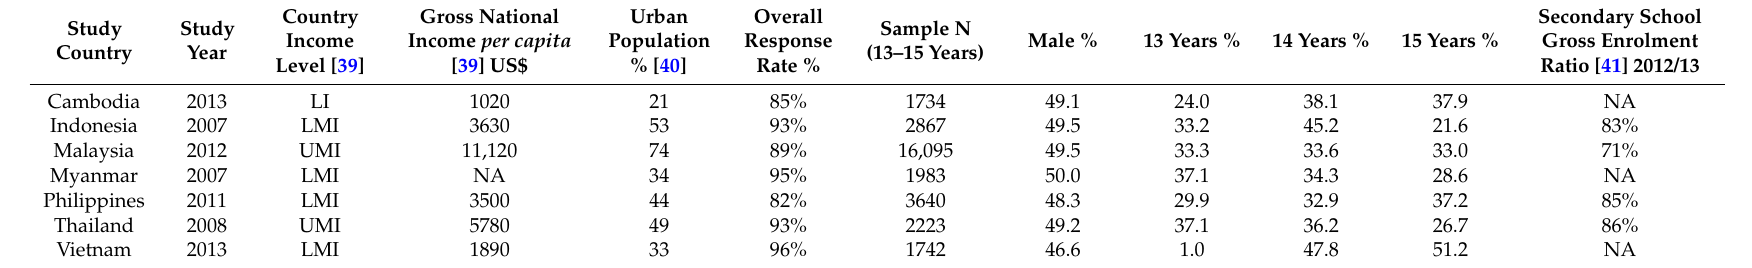
Table 2. Details of participating country samples included in the analyses (age 13–15 years only) ( N = 30,284).